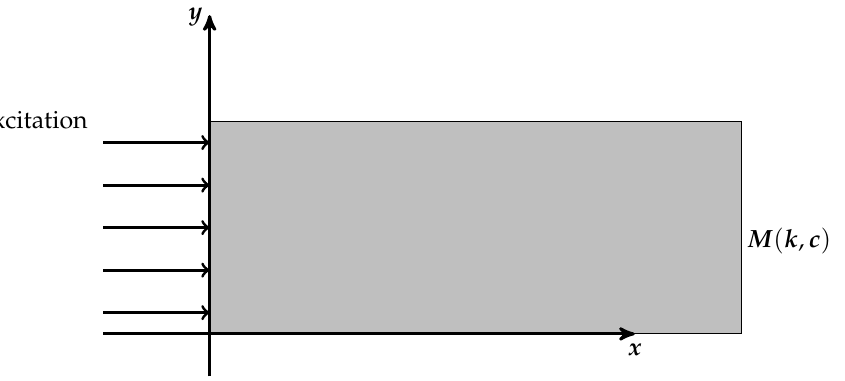
Figure 3. Thermal wave generation and propagation in a semi-infinite medium. Here, k denotes the thermal conductivity, and c denotes the volumetric heat capacity of the material M . The thermal diffusivity can then be calculated using α : = k √ kc thermal effusivity by e : =